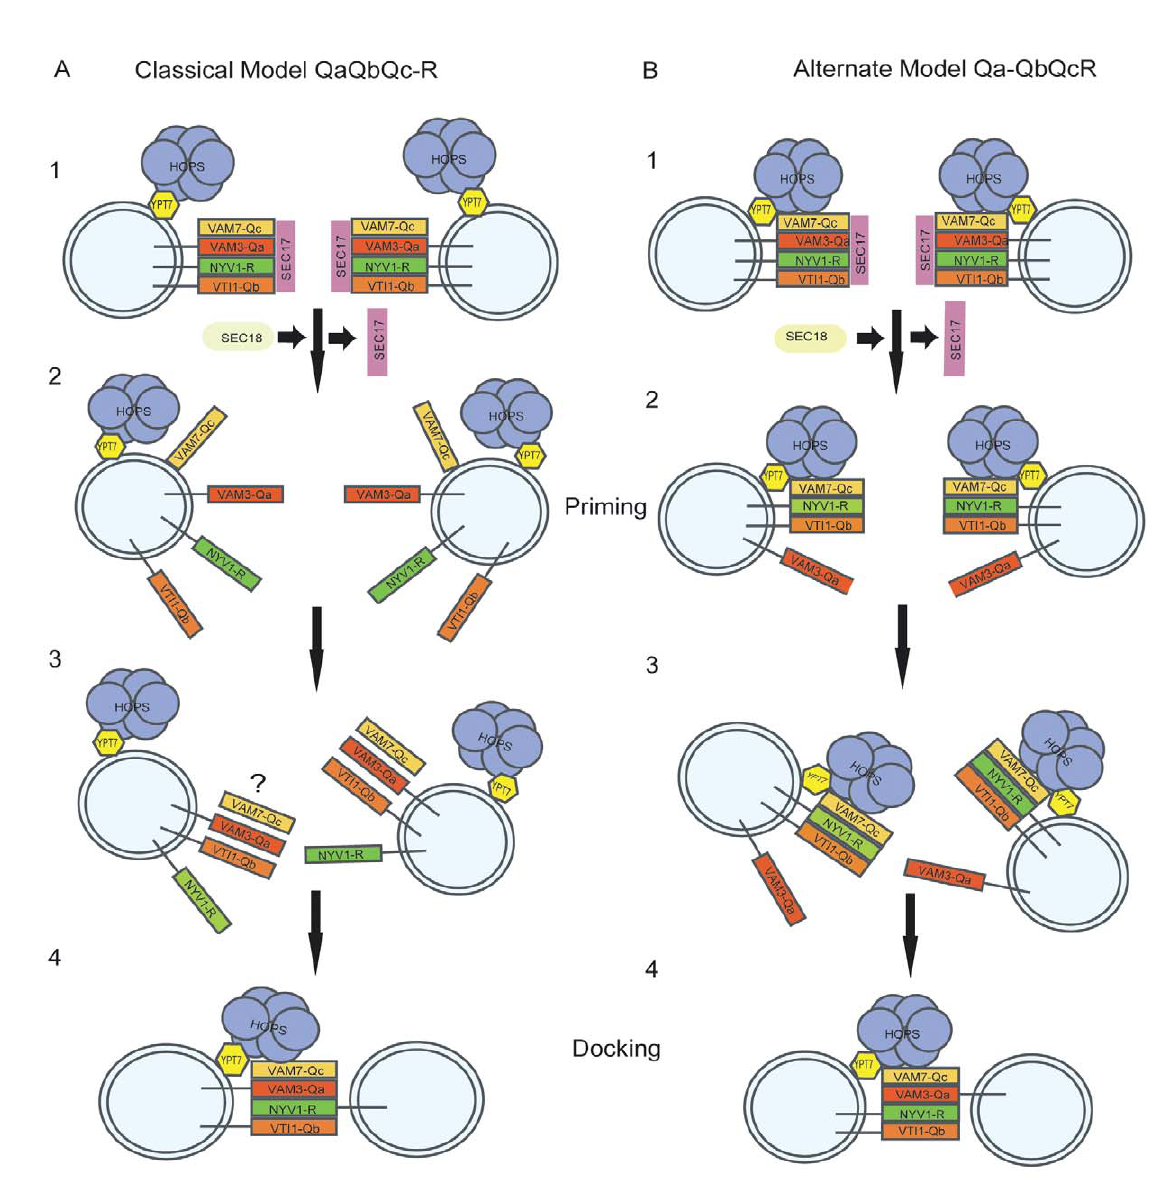
Figure 8. Different models for priming and docking. (A) According to the current model, SNAREs are totally separated by Sec18 (NSF) in the presence of ATP. Three Q-SNAREs reassemble to an acceptor complex probably catalyzed by tethering factors. The question mark indicates the fact that a trimeric Q-SNARE complex has not yet been identified on a physiological membrane. Finally, SNAREs dock and zipper up in a Q abc -R topology. (B) The alternate model comprises an activation step by Sec18 leading to a removal of the Q a -SNARE Vam3 and a persisting Q bc R-complex stabilized by HOPS/Ypt7. Subsequently, the SNAREs dock and zipper up in a Q bc R-Q a topology.